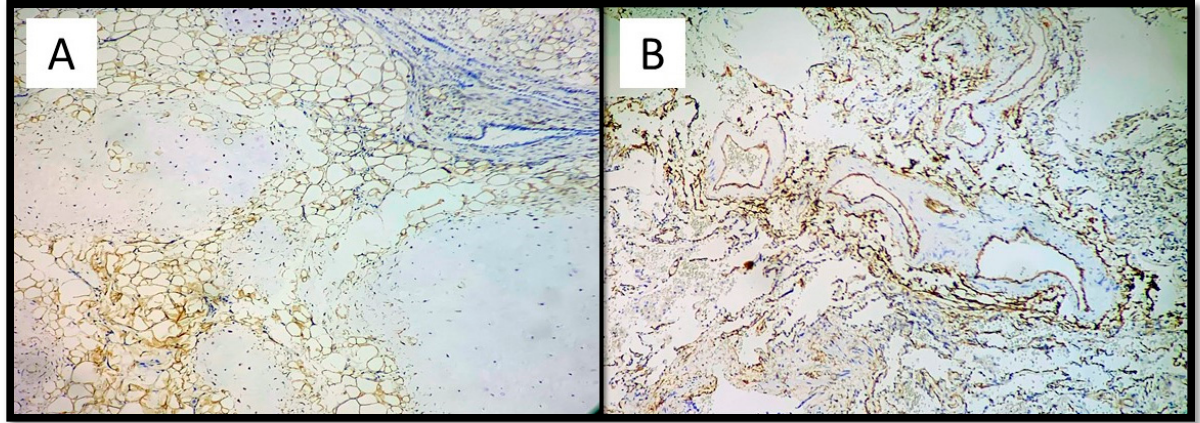
Figure 5. ( A ) Immunostaining for vimentin which shows positivity in the adipose component and negativity in the vascular and cartilage component of the hamartoma (immunohistochemistry, original magnification: 10×). ( B ) Immunostaining for CD34 showing extensive and widespread positivity in the vascular component of the hamartoma (immunohistrochemistry, original magnification: 10×).